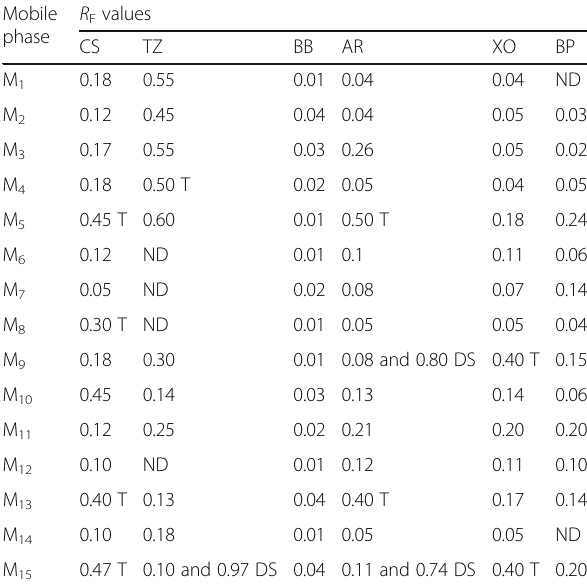
( R = 0.55). At lower concentration of 1- F